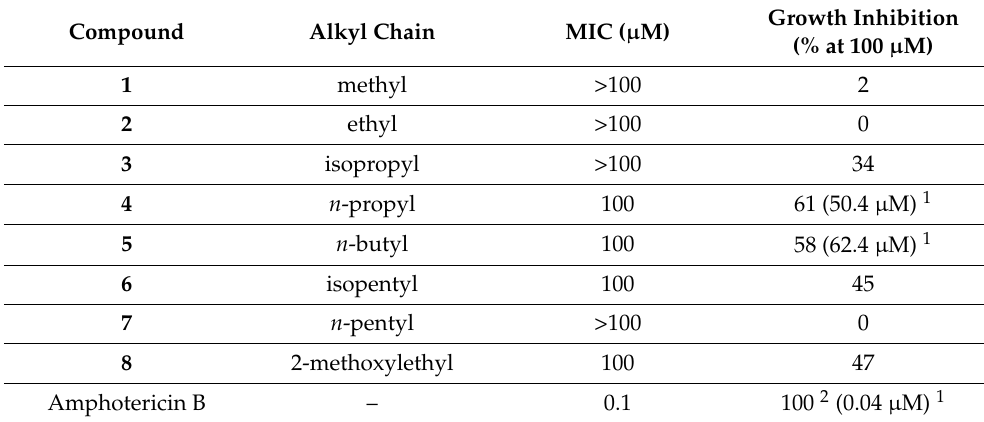
Table 2. In vitro leishmanicidal activity of gallic acid alkyl esters against promastigotes of L. major